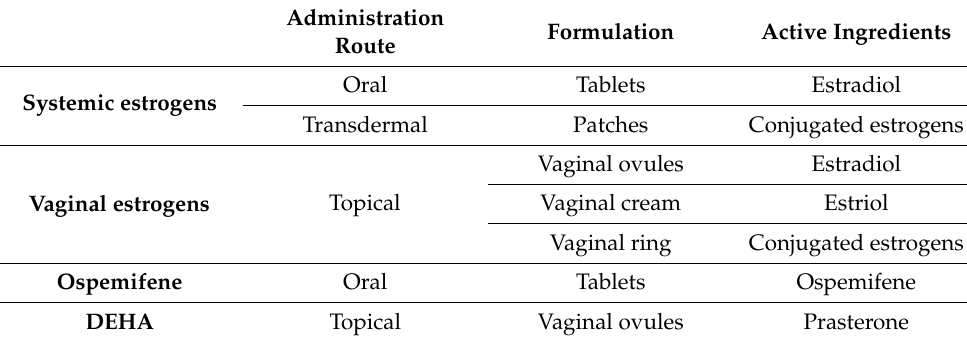
Table 1. Main pharmaceutical options for VVA